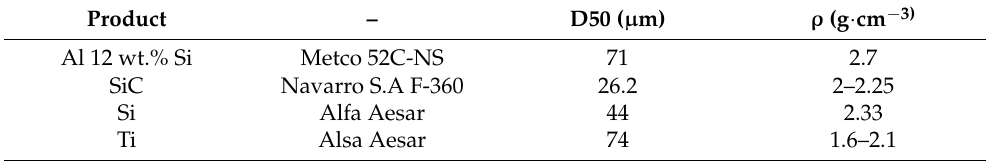
Table 1. Powder properties.